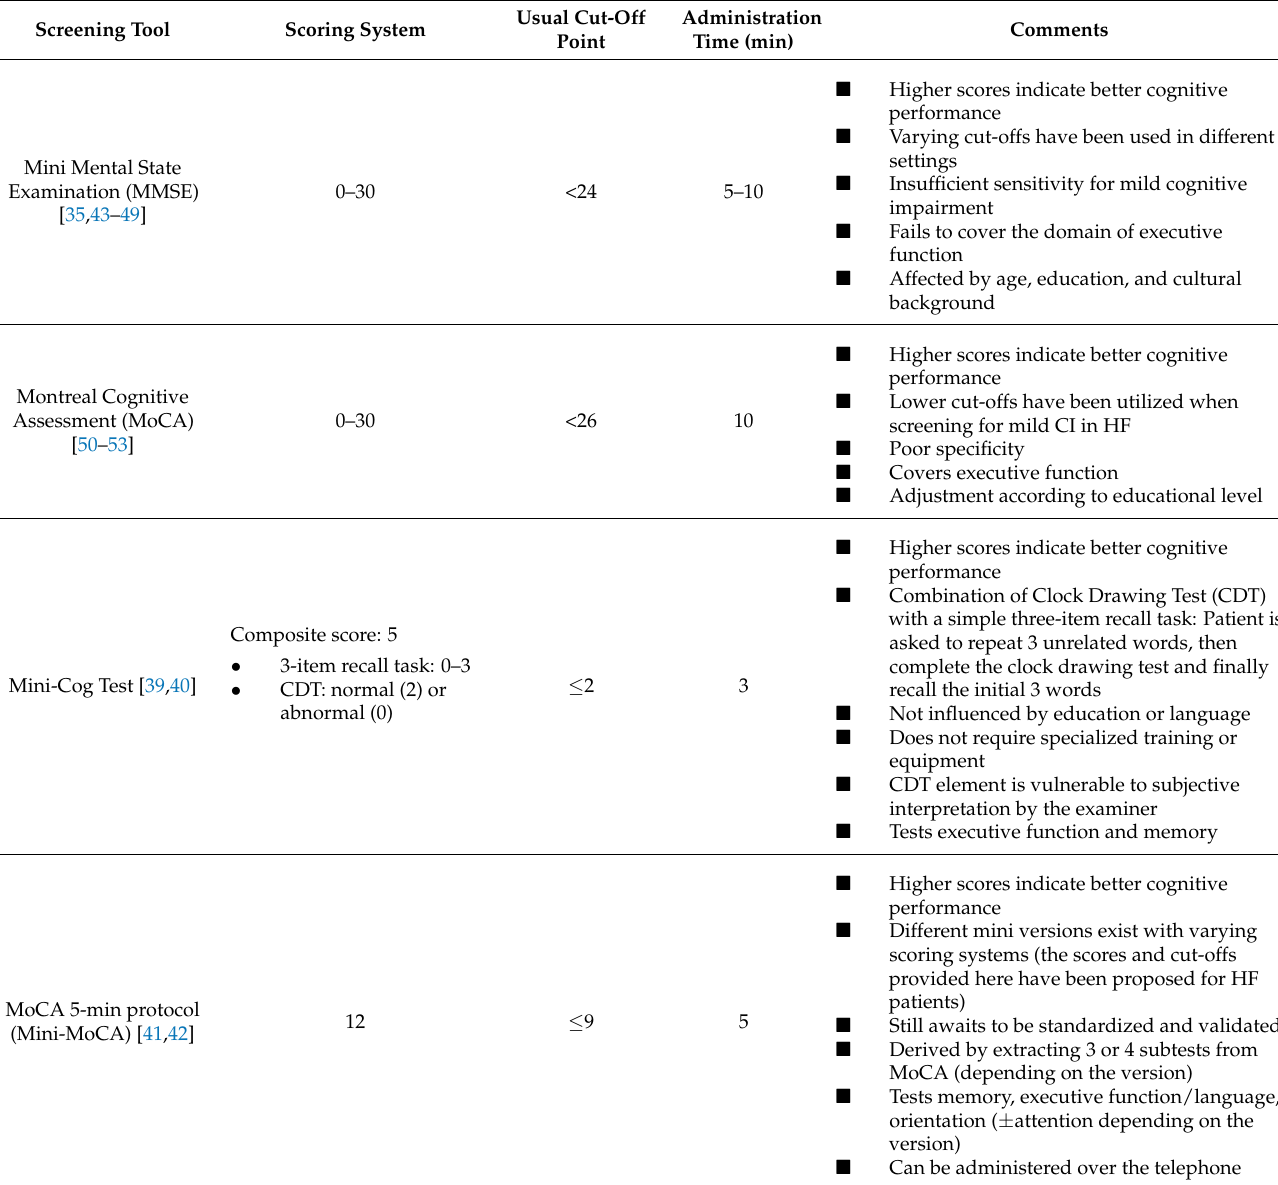
Table 1. Features of the most common and brief screening tools for the assessment of cognitive impairment in heart failure. Screening Tool Scoring System